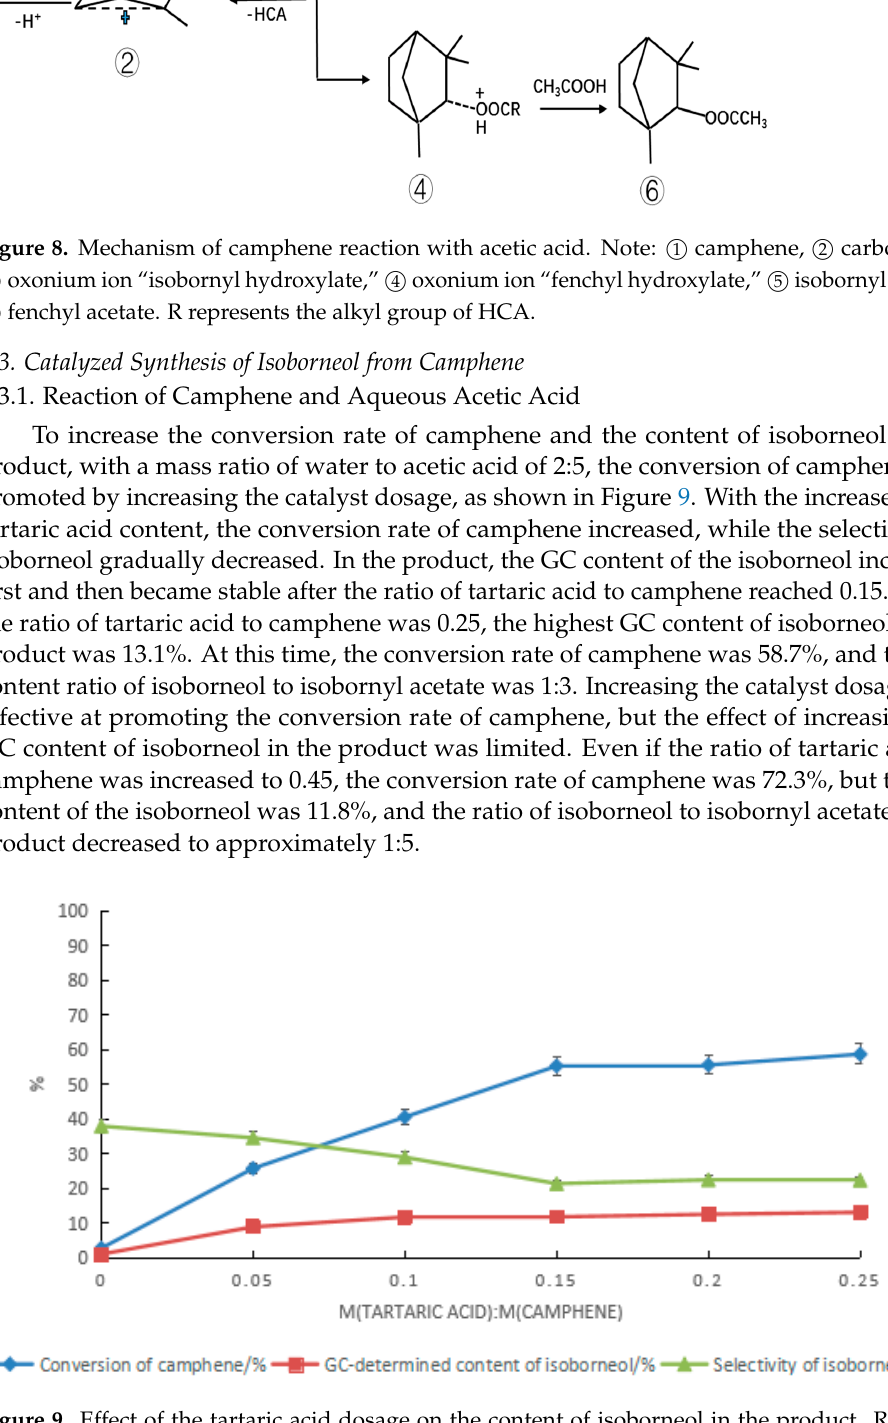
Figure 9. Effect of the tartaric acid dosage on the content of isoborneol in the product. Reaction conditions: m(camphene):m(acetic acid):m(water):m(boric acid) = 10:25:10:0.4, reaction temperature of 70 ◦ C, and reaction time of 24